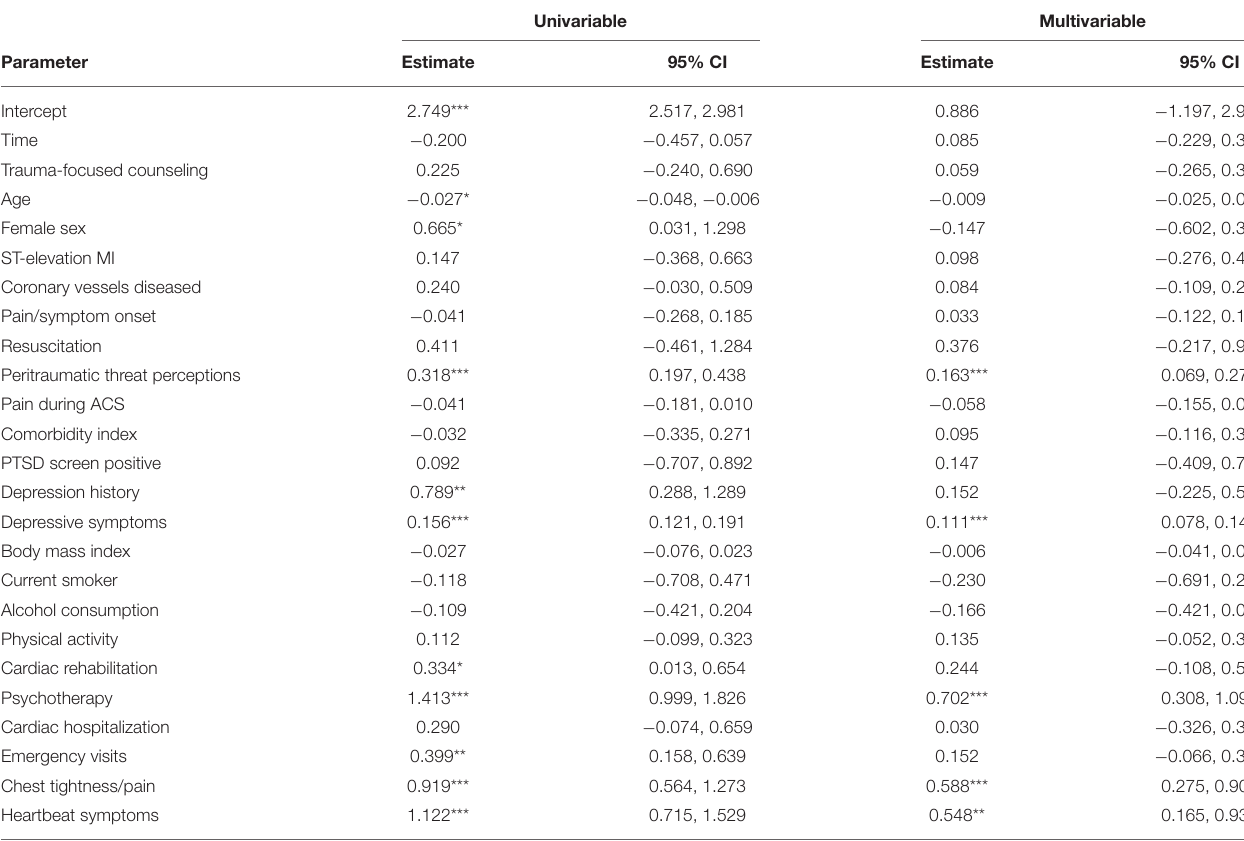
TABLE 2 | Relationships with total PTSD symptoms over 12 months.